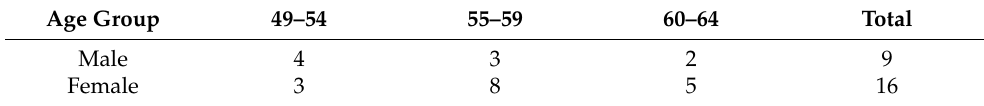
Table 2. Age profile of participants.